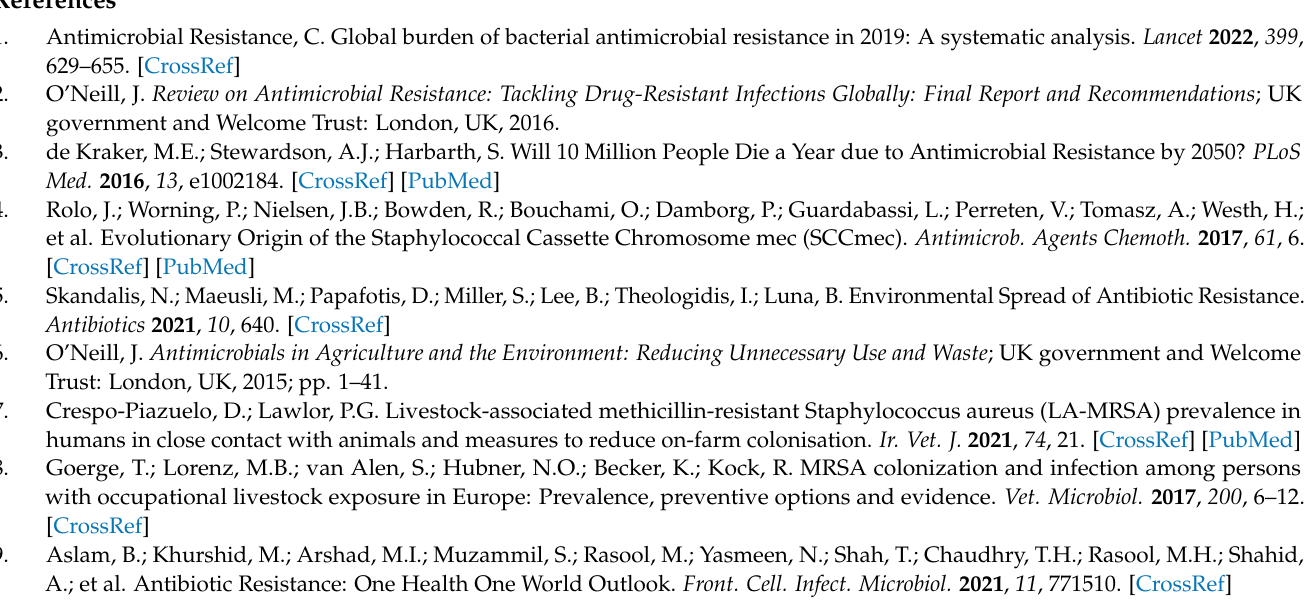
Table S1: Species distribution in the population. Table S2: Metadata as an excel file comprising the results of phenotypic antibiotic susceptibility test and genotypic screening of antimicrobial resistance genes for all the isolates. Table S3: (i) Number of isolates displaying phenotypic and genotypic resistance for the antibiotic classes tested (ii) Statistical analysis data of phenotypic and genotypic resistance distribution in the different farm types *. Figure S2: Antibiogram of the isolates harbouring multiple resistance determinants (MRD) in the